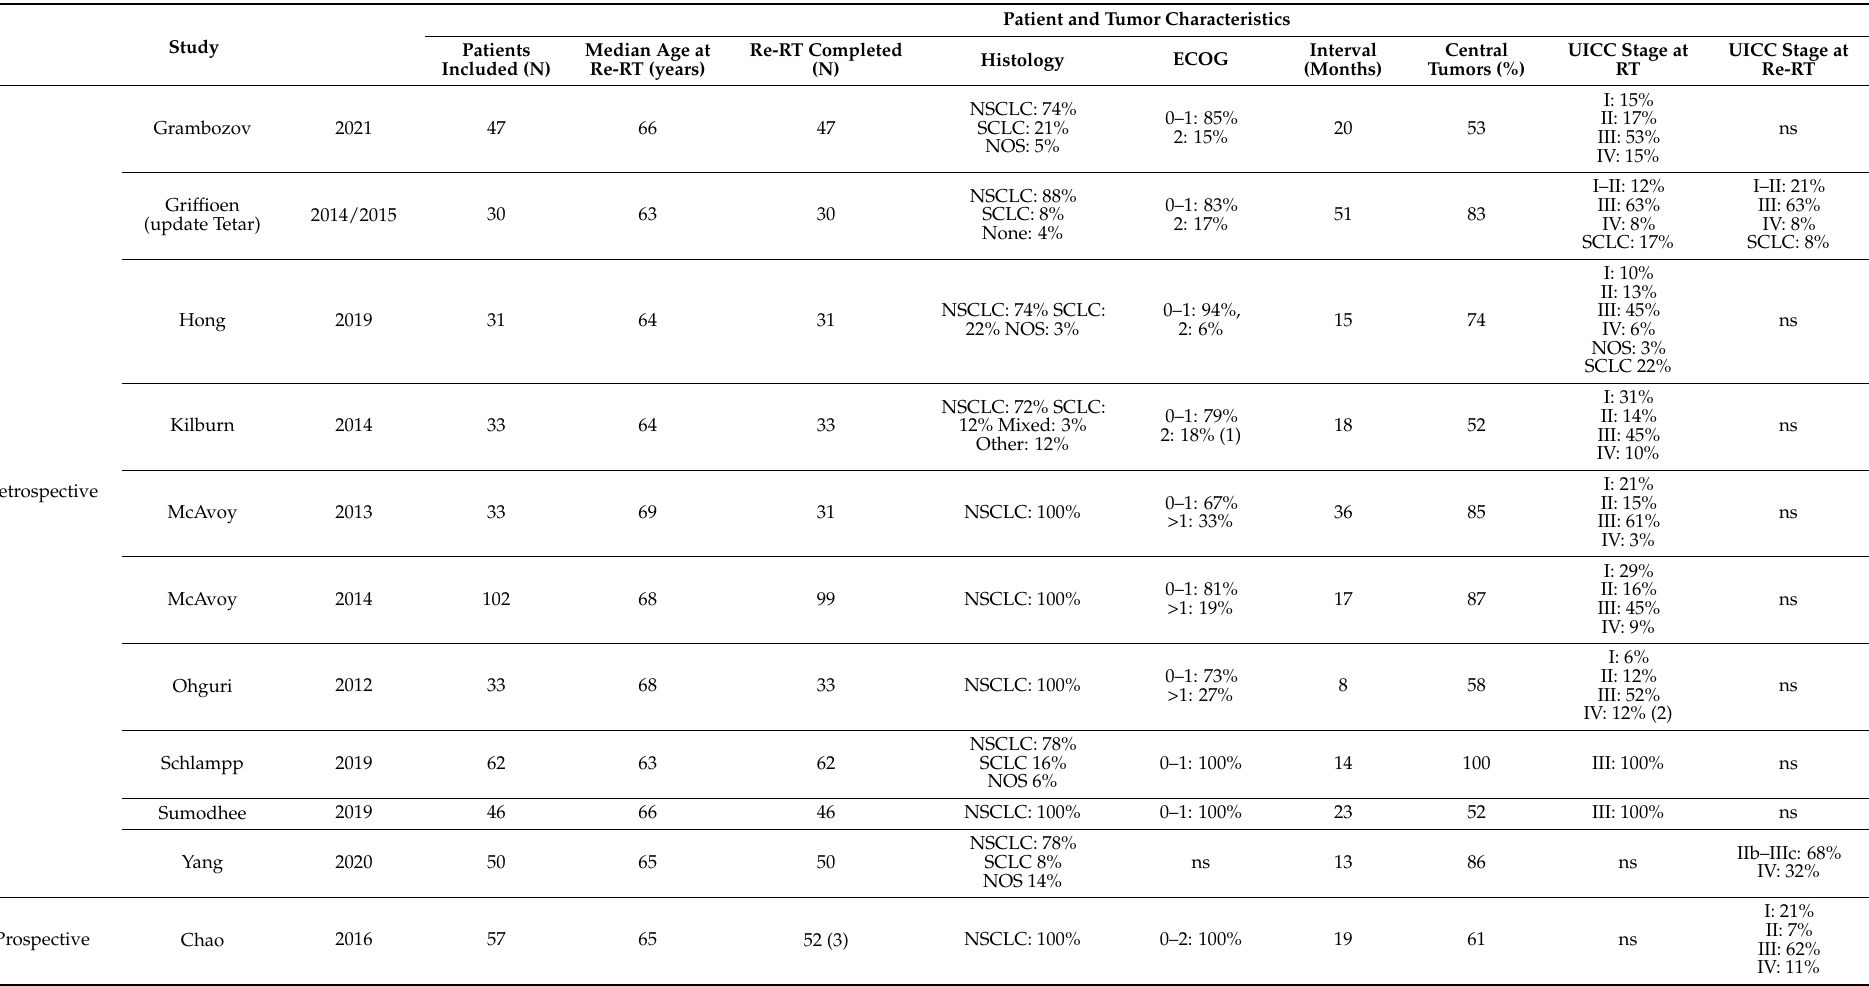
Table 1. Patient and tumor characteristics in the selected studies (ns = not